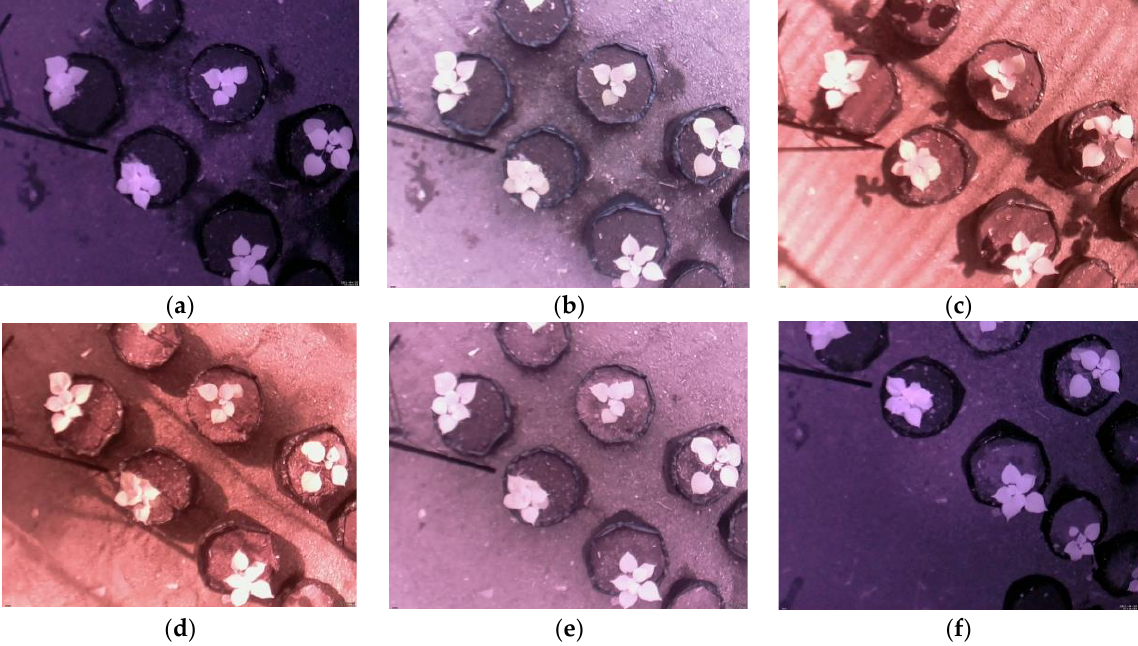
Figure 3. Images of Ramie plants taken at different times: ( a ) 03:00; ( b ) 07:00; ( c ) 10:00; ( d ) 14:30; ( e ) 16:50; ( f ) 21:00.